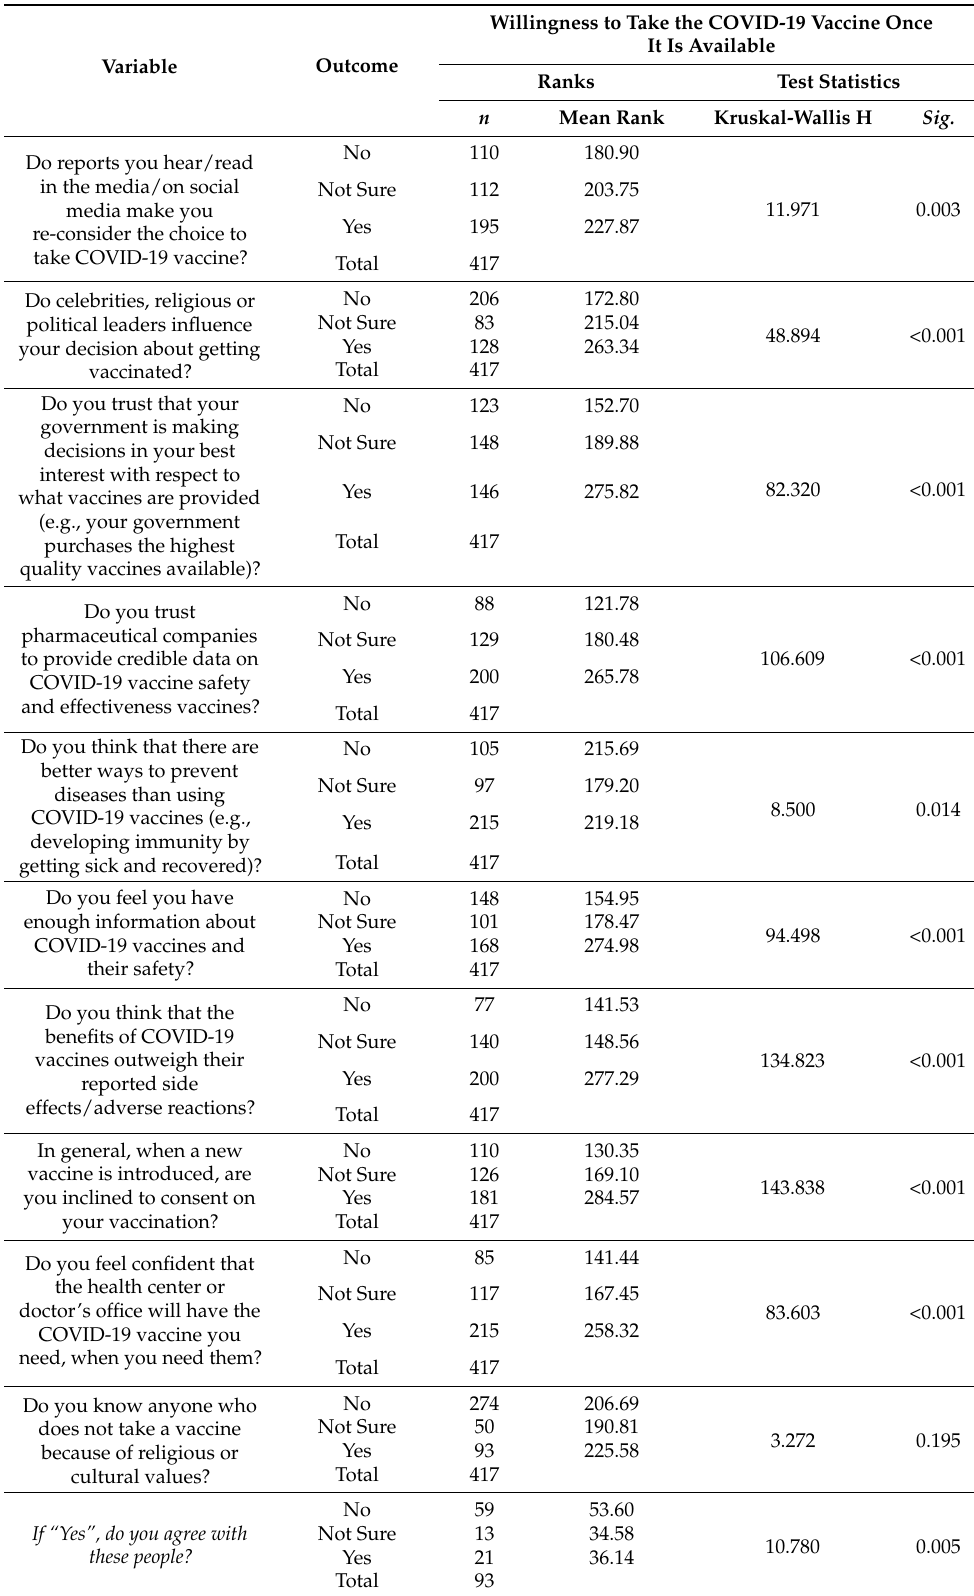
Table 6. Predictors of Palestinian dental students’ willingness to receive COVID-19 vaccine, February—March 2021 ( n = 417). Willingness to Take the COVID-19 Vaccine Once It Is Available Variable Outcome Ranks Test Statistics n Mean Rank Kruskal-Wallis